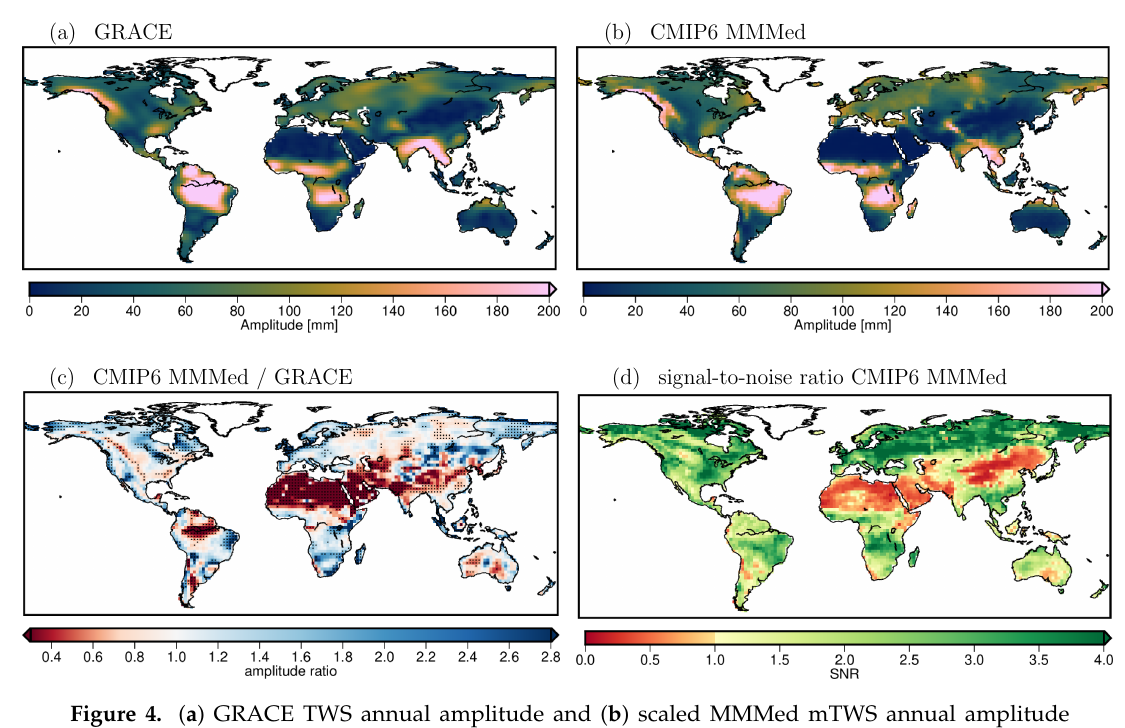
Figure 4. ( a ) GRACE TWS annual amplitude and ( b ) scaled MMMed mTWS annual amplitude for the time span 2002/04–2020/04. ( c ) Ratio of ( b ) and ( a ). Stippling indicates regions where the deviation from 1 exceeds the standard deviation of the ratio. ( d ) MMMed mTWS annual amplitude signal-to-noise ratio.